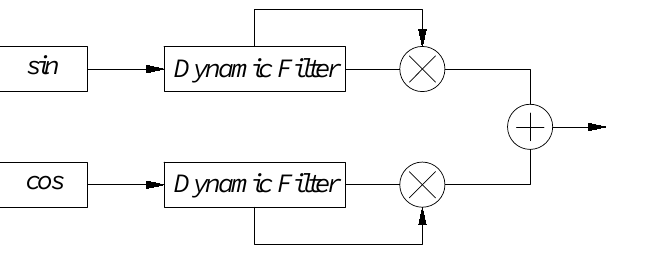
Figure 15. Schematic diagram of a hardware − in − the − loop simulation to prove that the filter does not cause amplitude abrupt changes.